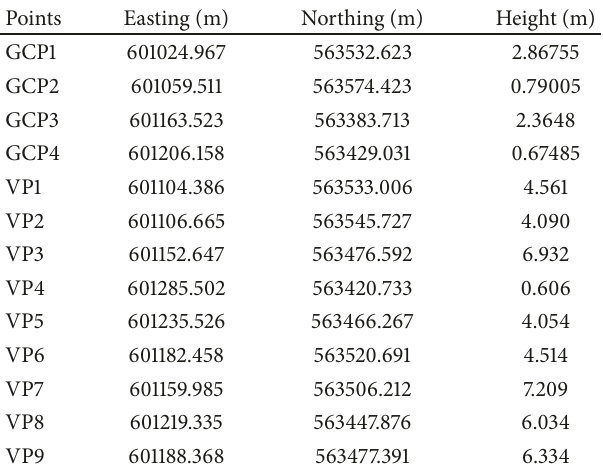
Table 3: GCPs and VPs